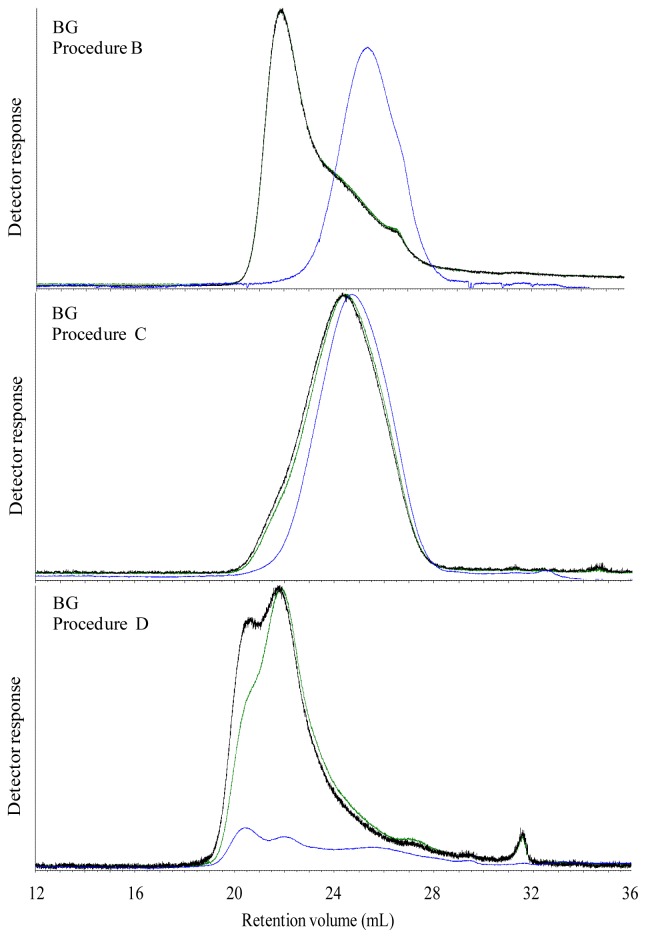
Size exclusion chromatography with RALLS (green), LALLS (black) and intrinsic viscosity (blue) signal of extracts of water extracted (procedure B), in vitro digested (procedure C), and in vivo digested (procedure D) BG bread.